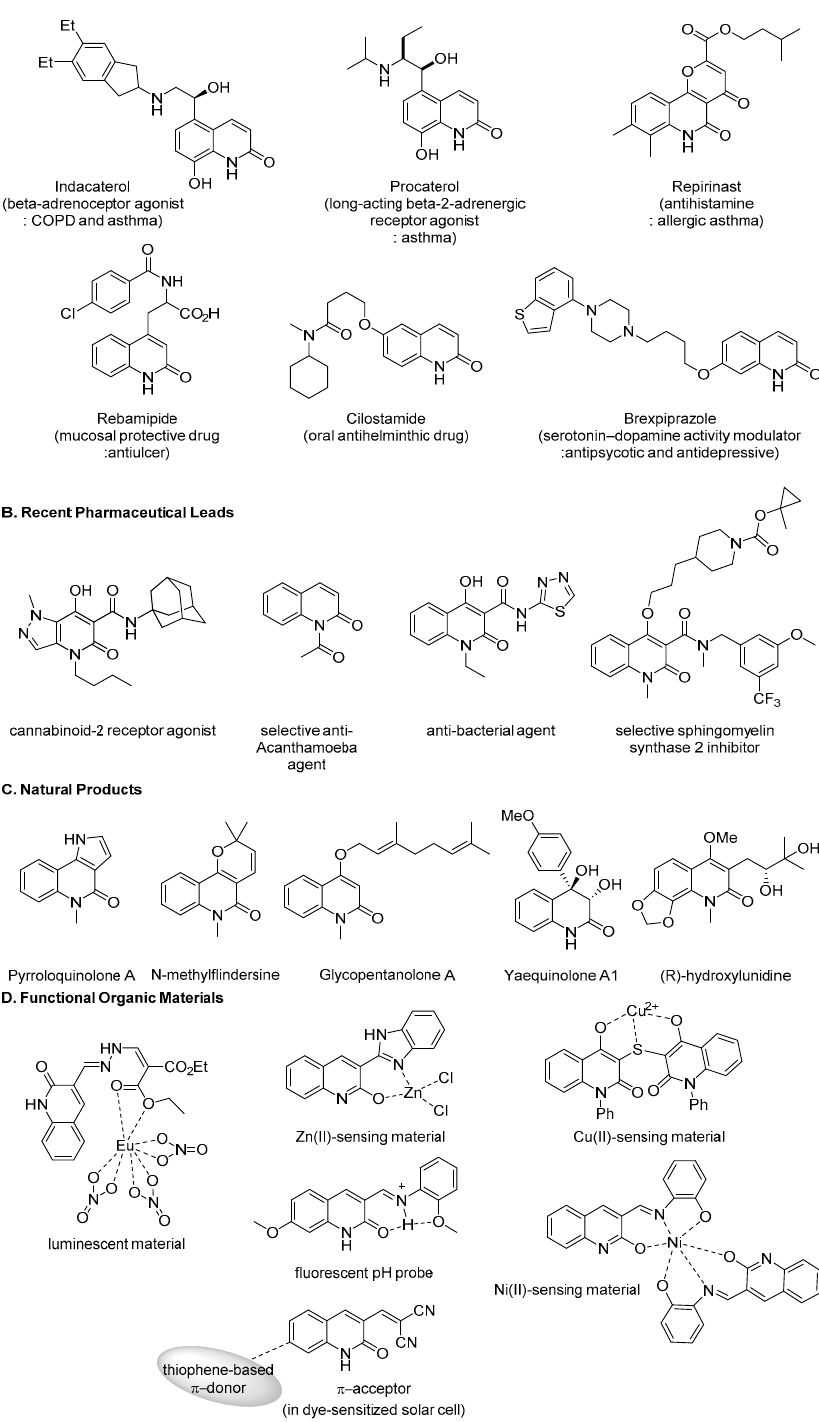
Figure 1. Recent examples of functional molecules containing 2-quinolone scaffold.